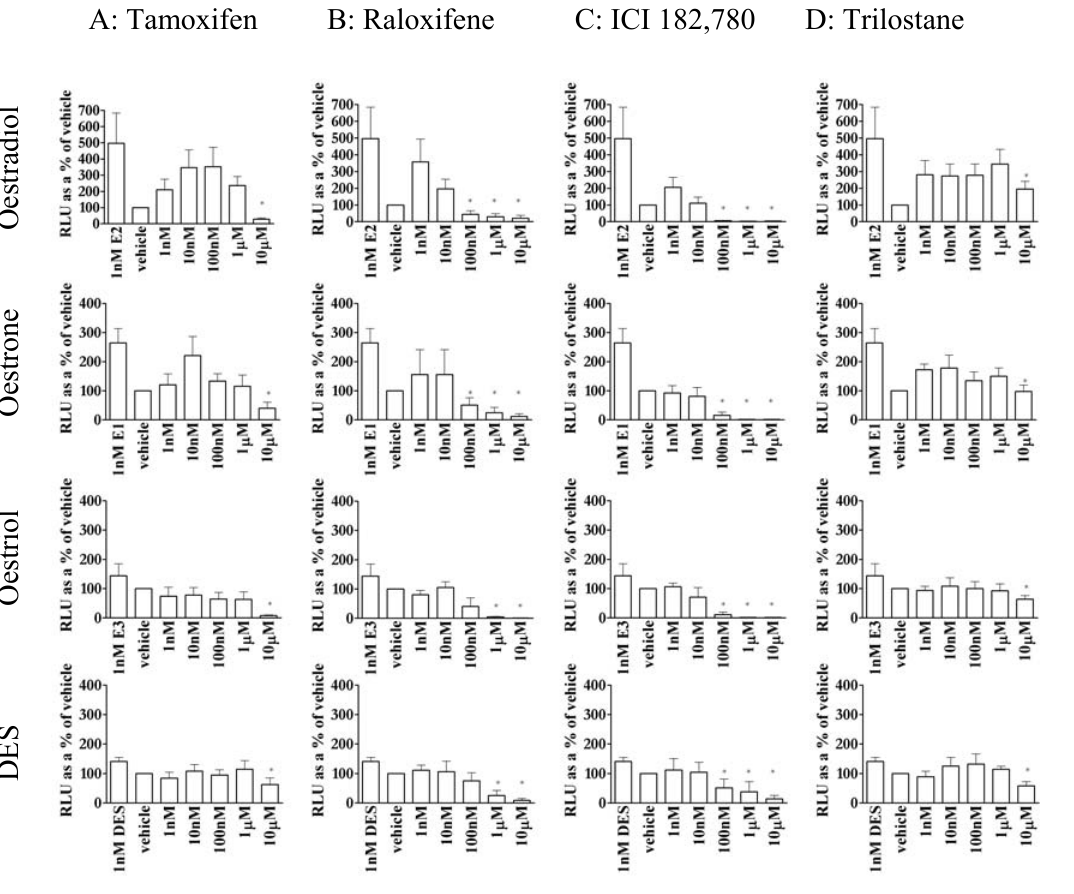
Figure 4. Antioestrogen repression of 1nM E2, E1, E3 or DES-stimulated reporter activity. Tamoxifen (4A), raloxifene (4B), ICI 182,780 (4C) and trilostane (4D) were co-treated with E2 (row 1), E1 (row2), E3 (row3) or DES (row4). Results are expressed as Relative Light Units (RLU) compared to vehicle-only wells (=100%). * = significant stimulation/repression (P < 0.05) above/below basal. B: Raloxifene C: ICI